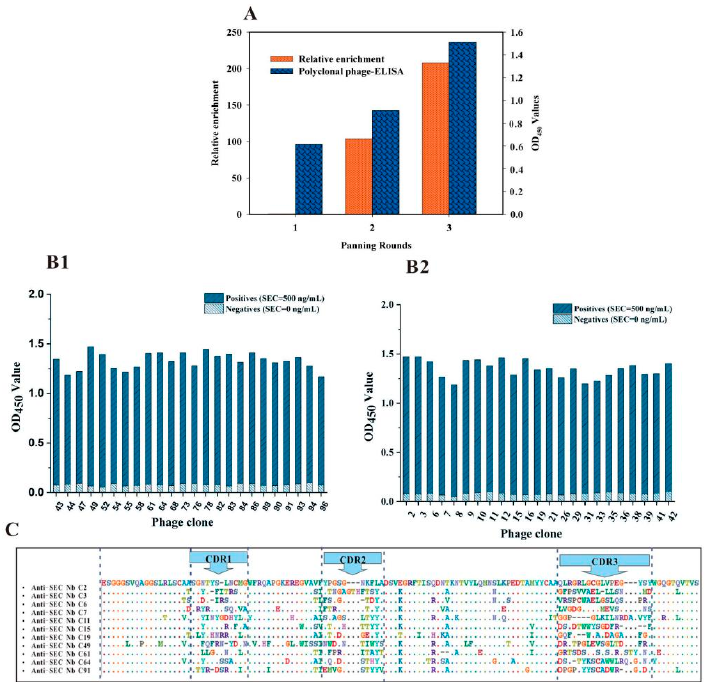
Figure 2. Biopanning of the anti-SEC Nbs. ( A ) The enrichment of the eluted phage during the bi- opanning cycles. ( B1 and B2 ) Screening and identification of the anti-SEC Nbs via indirect phage- ELISA. ( C ) The anti-SEC Nbs amino acid sequence alignment was categorized into 11 families due to significantly diverse amino acid sequences in the CDR3.